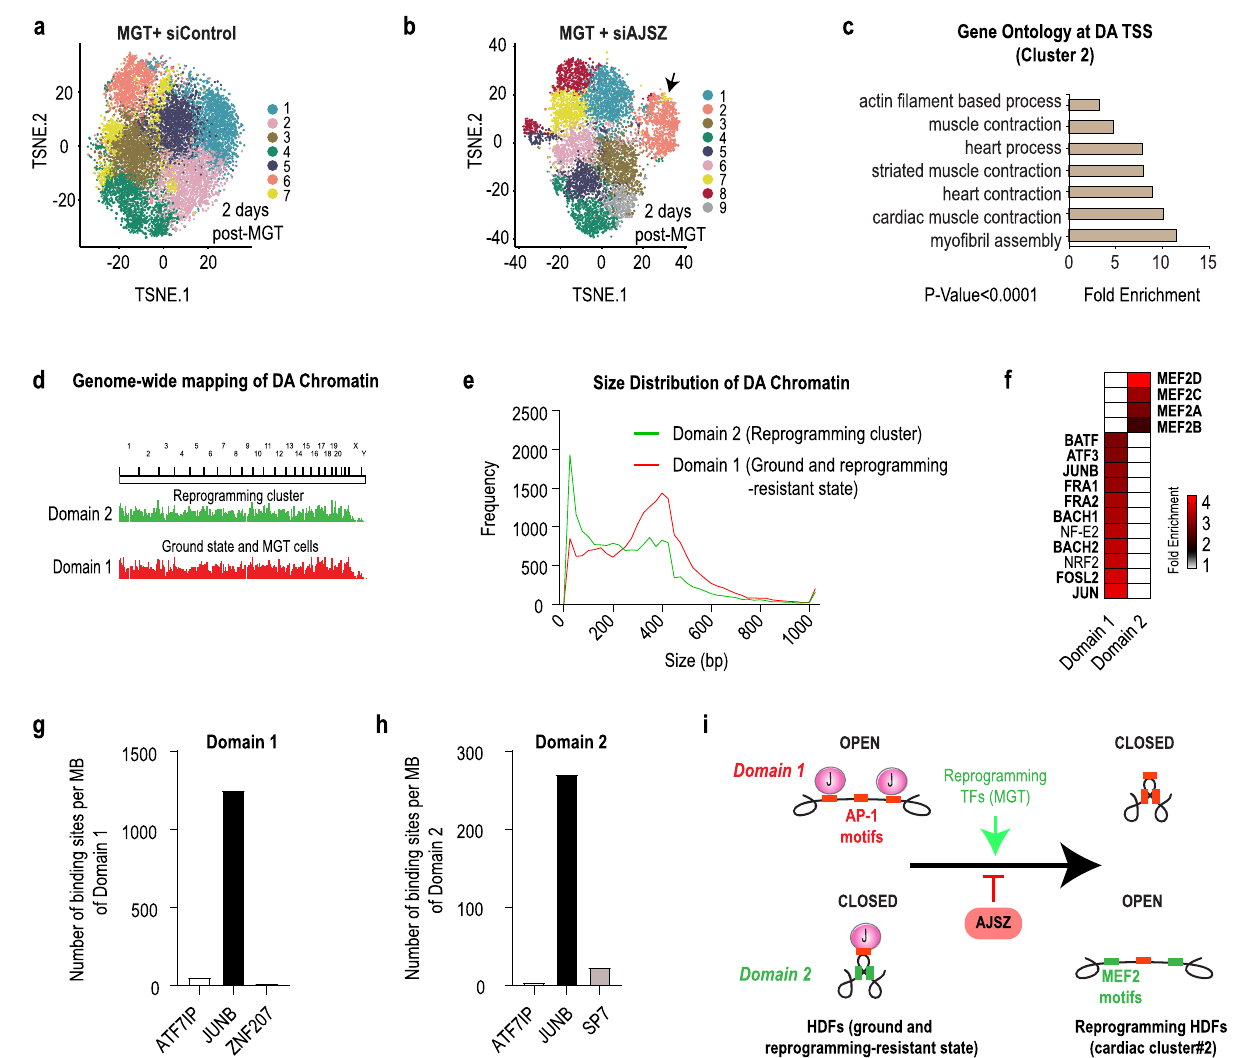
e Sizedistributionofdifferentiallyaccessiblechromatinregionsindomains1and2. f Most differentially enriched TF motifs in domain 1 as compared to 2 and con- versely. g , h AJSZbindingdensityindomain1( g )and2( h )atgroundstateinHDFs. i Model summarizing the role of AJSZ in the regulation of chromatin accessibility during cell fate